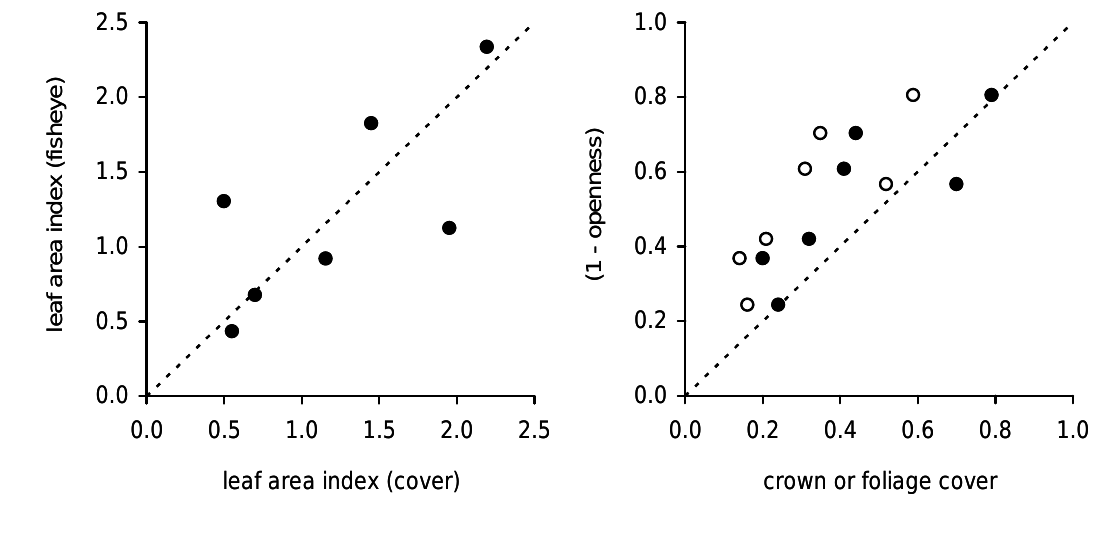
Figure 7. Comparison of leaf area index calculated after Lang and Xiang [40], and gap fraction, from full-frame fisheye photography with leaf area index and either crown cover or foliage cover obtained from DCP. Open circles represent data plotted against foliage cover and closed circles represent data plotted against crown cover. The dashed line is the 1:1 line. All data are from large JPEGs collected using the Nikon D80 DSLR. Each data point is the mean of 5 full-frame fisheye images or 25 cover images. Standard errors (not shown) were between 0.07 and 0.16 for leaf area index and 0.01 and 0.05 for crown and foliage